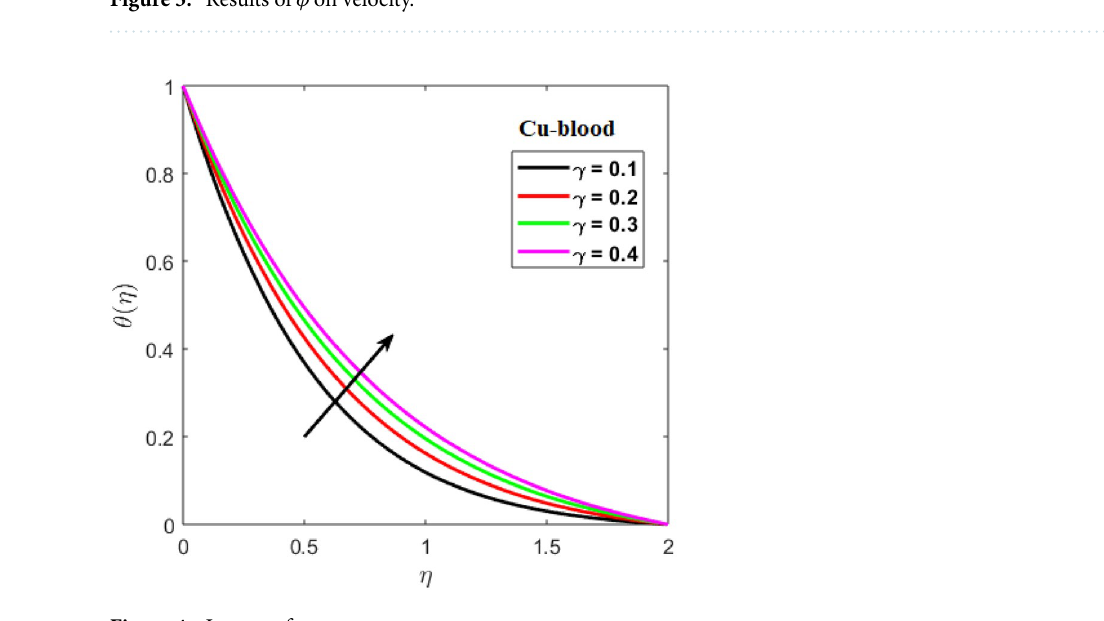
Figure 3. Results of φ on velocity.